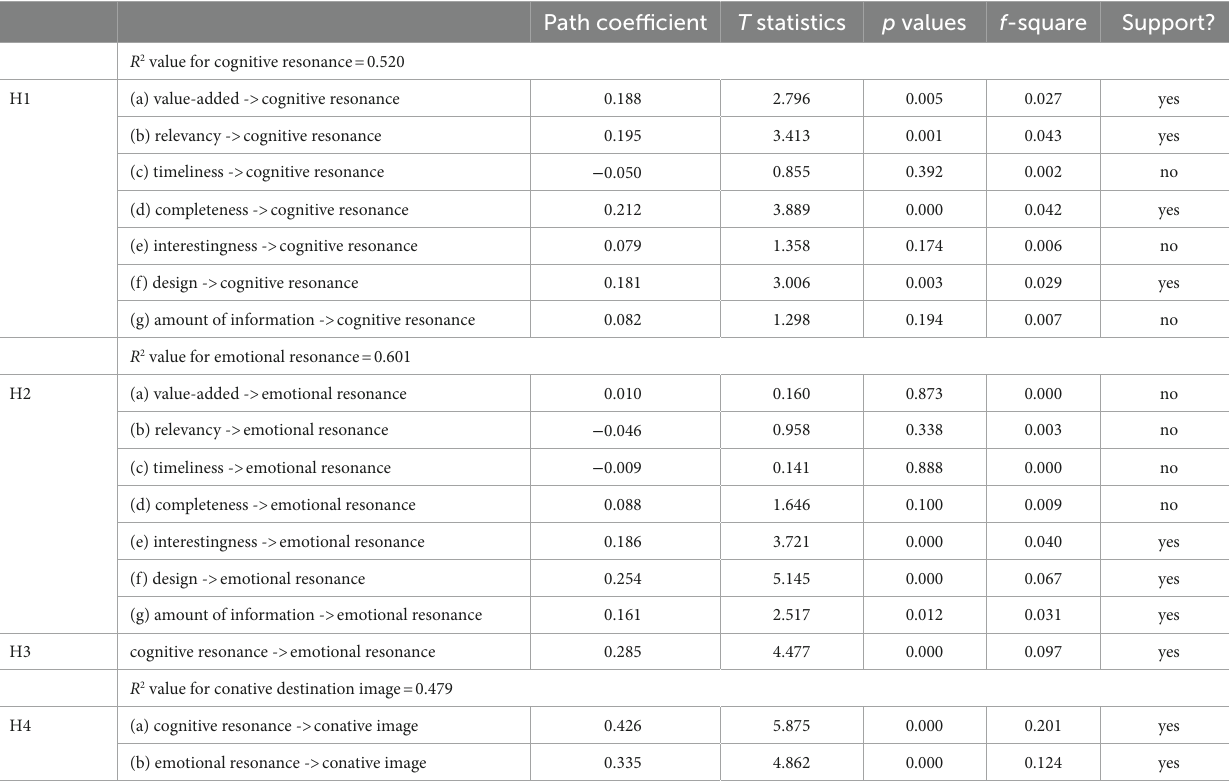
TABLE 5 Results of the hypothetical model of PLS-SEM.